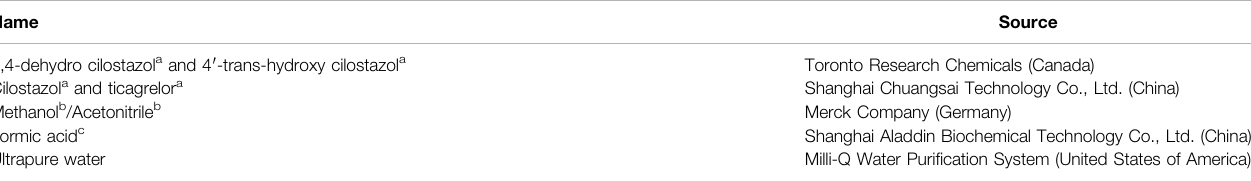
TABLE 1 | List of chemicals and reagents.